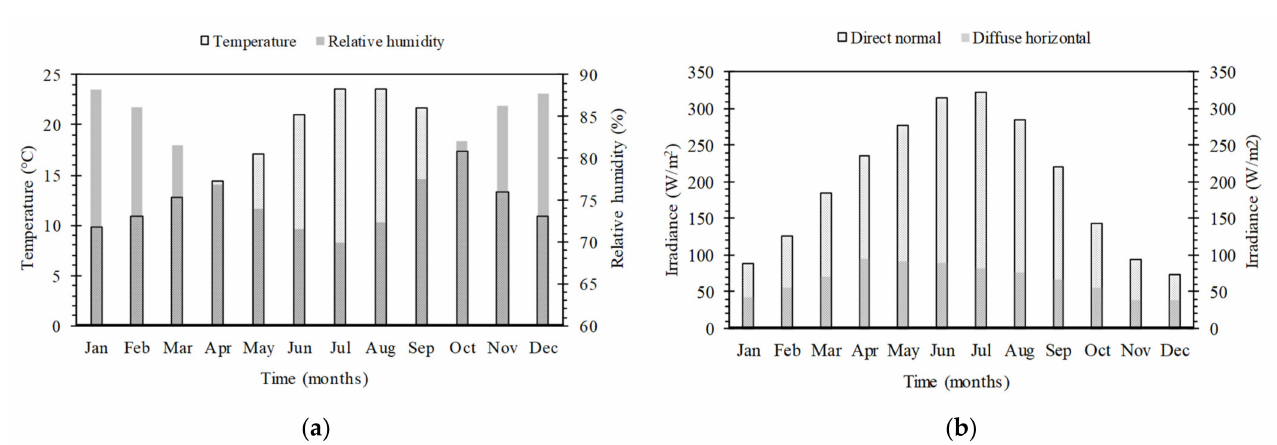
Figure 6. Weather data for Pombal region: ( a ) average monthly air temperature and relative humidity; ( b ) average monthly solar